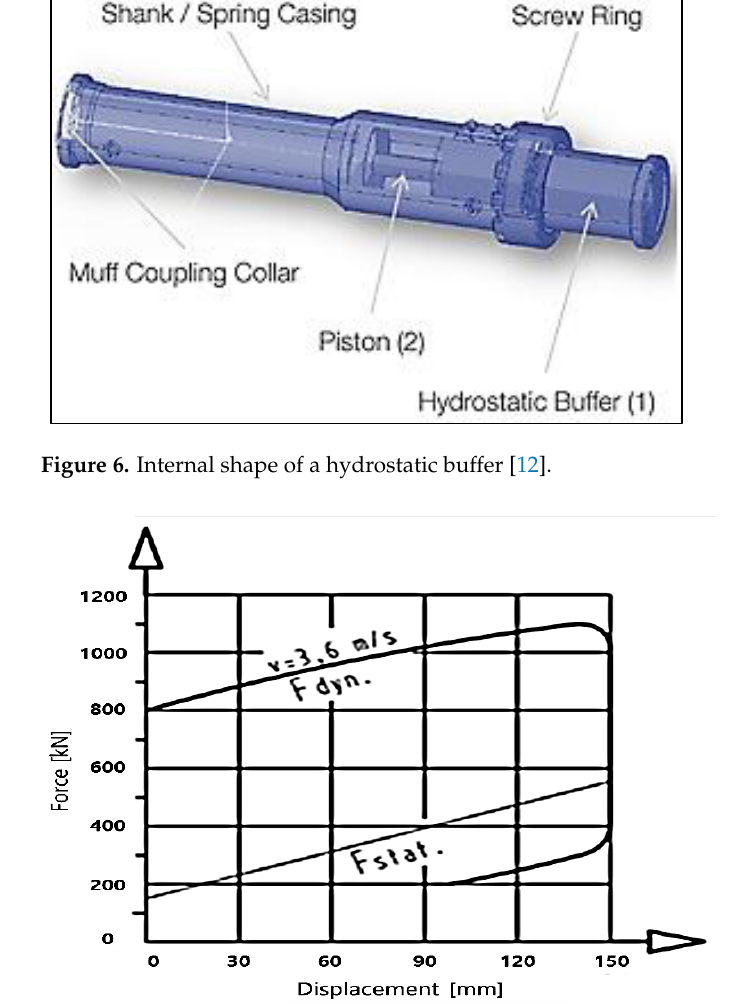
Figure 7. Typical characteristic curve of a hydrostatic buffer [12].